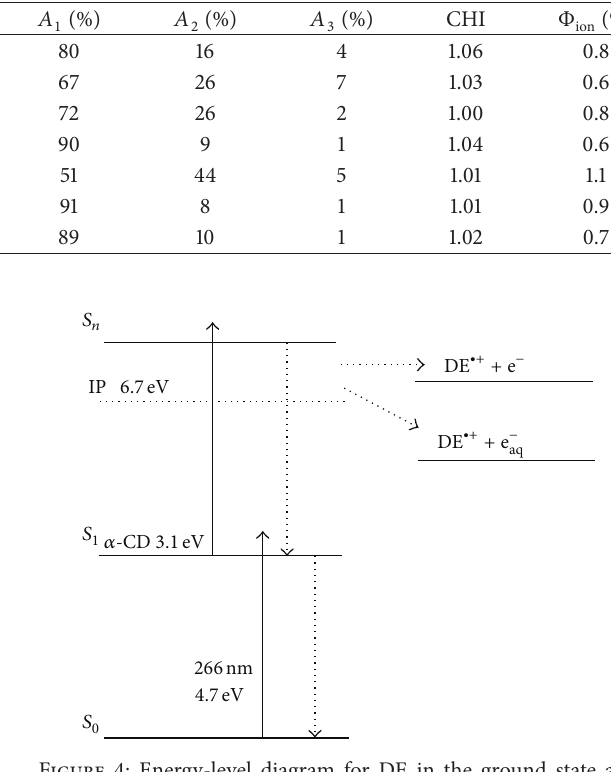
Figure 4: Energy-level diagram for DE in the ground state and excited state.